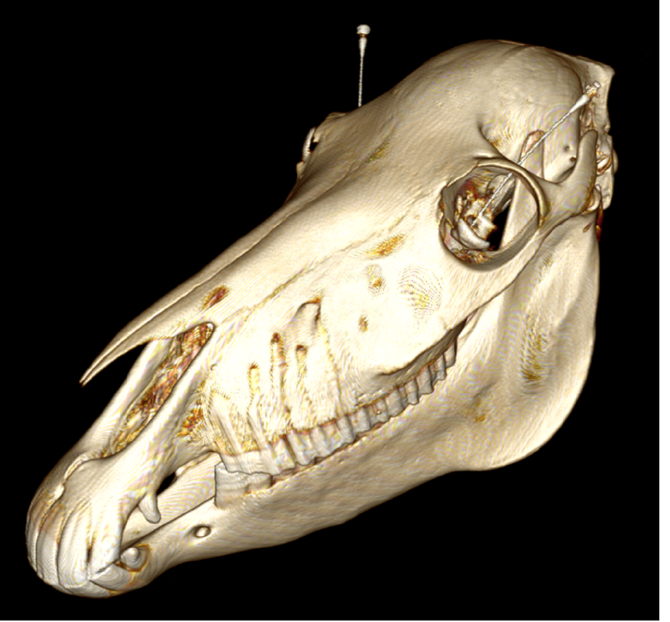
Figure 2. 3D reconstruction of a CT image of a cadaver head after the RNB with the needles in place. Bilaterally, the spinal needles are visible in the optical cone.